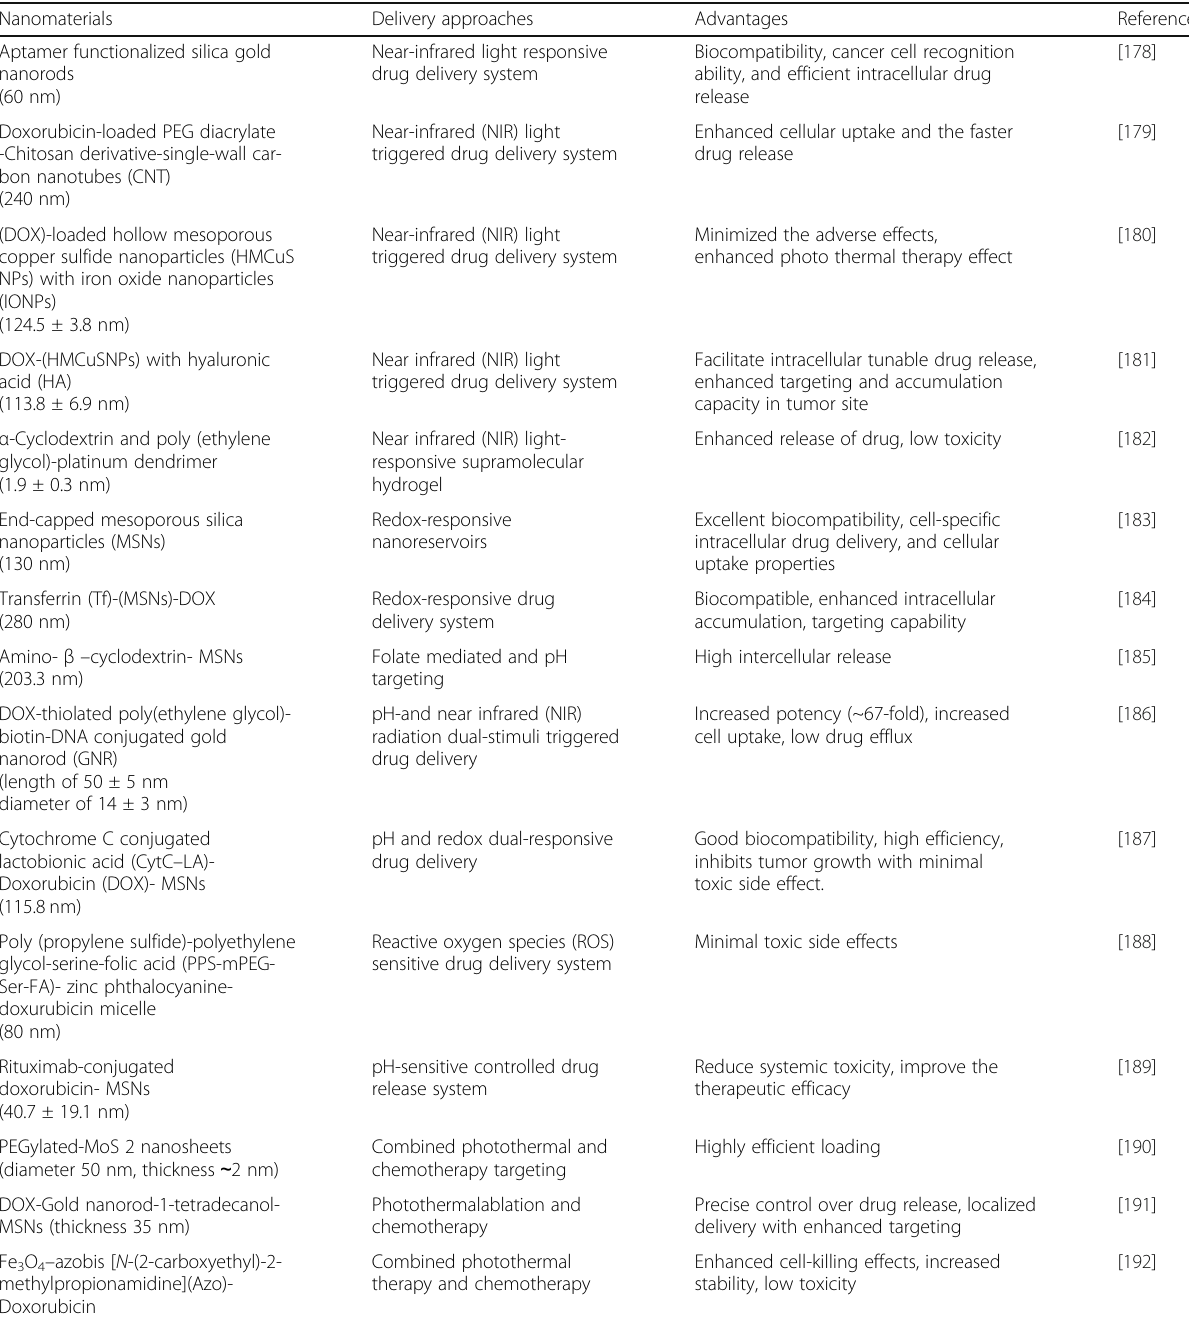
Table 3 Nanomaterials and drug delivery approaches for tumor